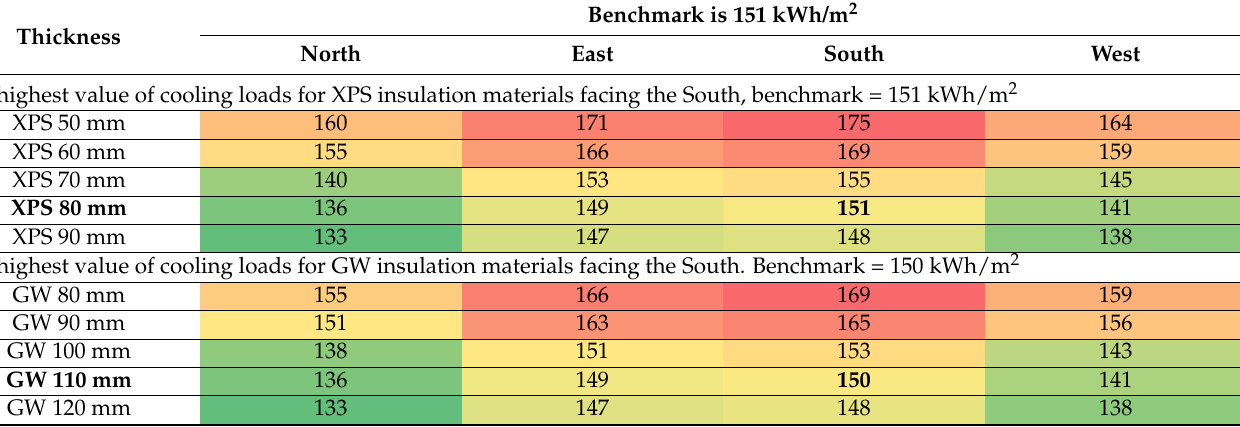
Table 4. The highest value of cooling loads for XPS, GW, EPS, and RW insulation materials facing the South .